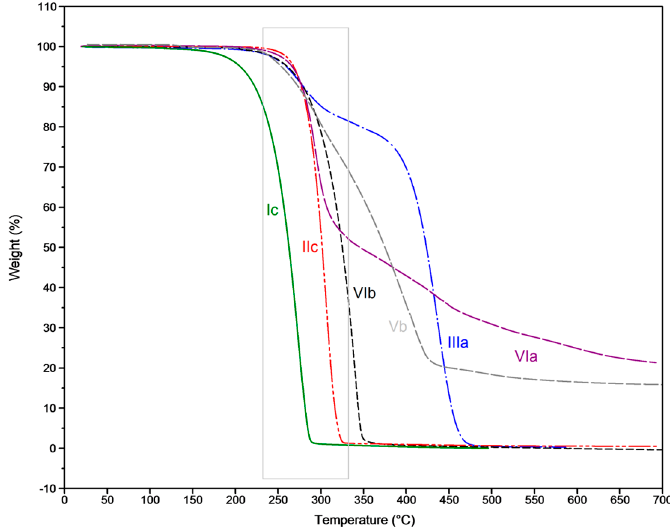
Figure 3. Collected thermogravimetric analysis (TGA) graphs of sulfenamides denoted Ic, IIc, IIIa, Vb, VIa and VIb. The optimal temperature range for flame retardant (FR) decomposition between polypropylene (PP) processing (230 °C) and ignition temperatures (250–360 °C) is marked with a grey border.